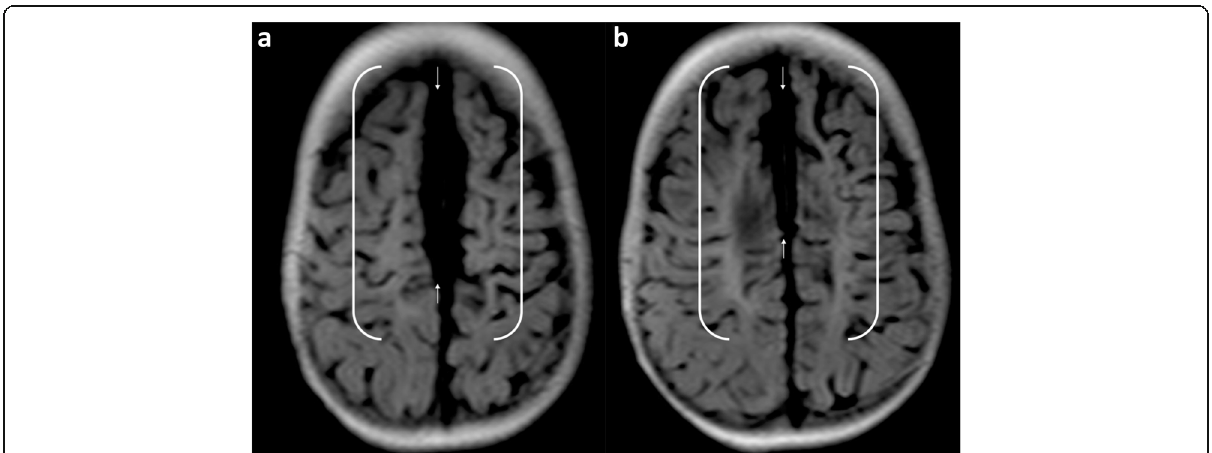
Fig. 10 a , b Sequential axial FLAIR images in a 2-year-old girl who sustained a partial-prolonged HII at term gestation, demonstrating volume loss and abnormal signal involving the parasagittal and anterior inter-vascular watershed regions in continuity (between white brackets) and sparing of the peri-Sylvian and posterior watershed. There is bi-convex expansion of the inter-hemispheric fissure at the anterior vertex (white arrows) indicating the predominant parasagittal involvement